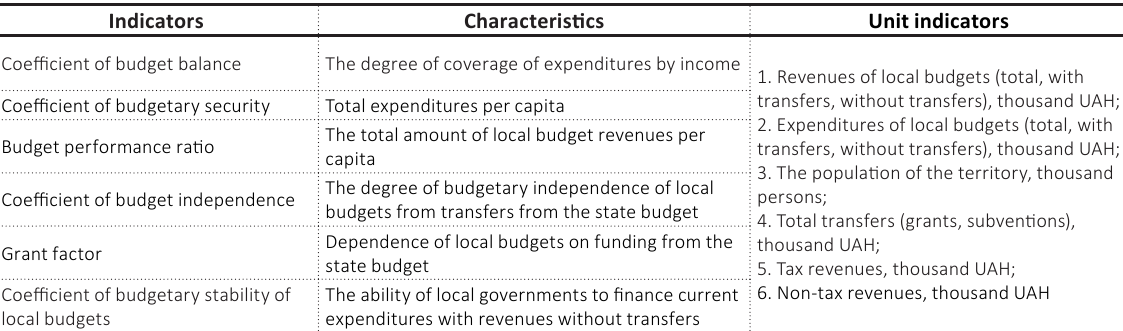
Source: Systematized by the authors.